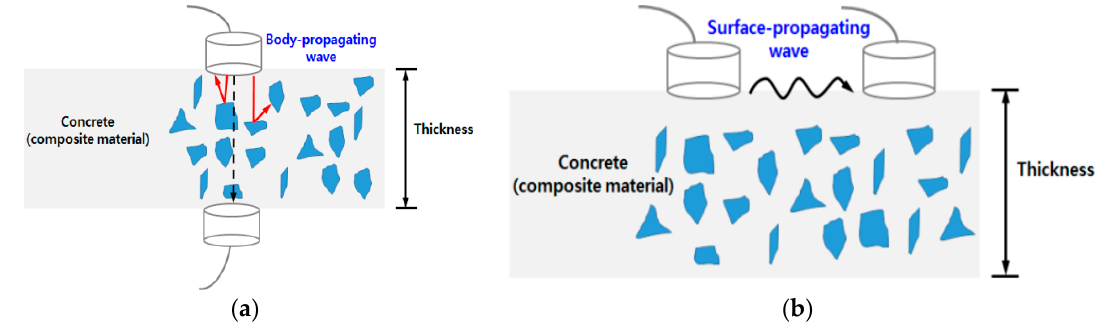
Figure 1. Schematic description of wave propagation in concrete: ( a ) body-propagating wave and ( b ) surface-propagating wave.